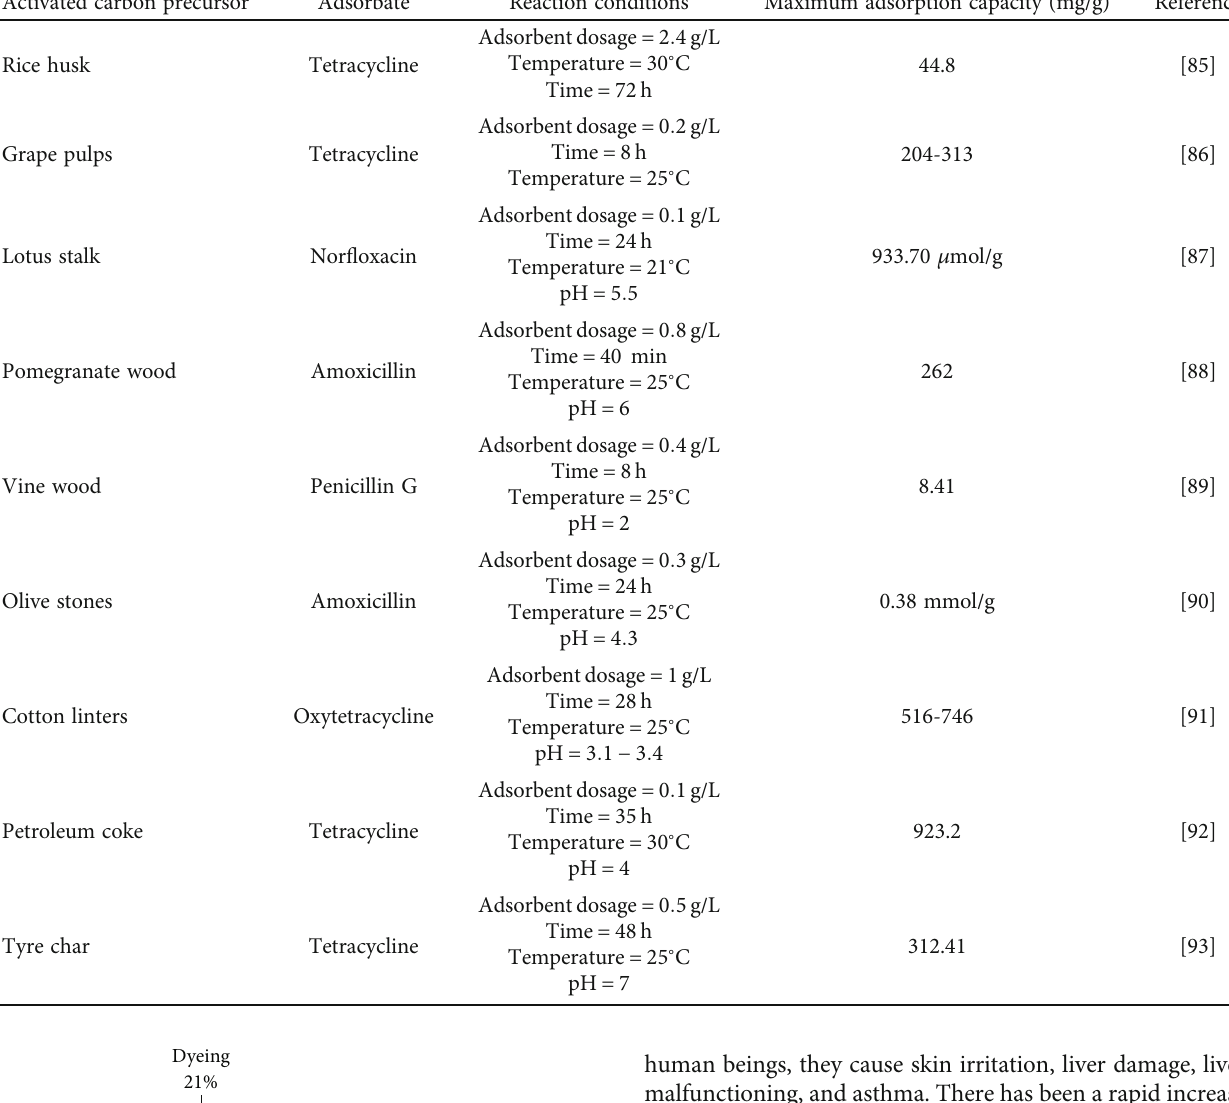
Table 5: Adsorption of various pharmaceutical and personal care products onto AC.